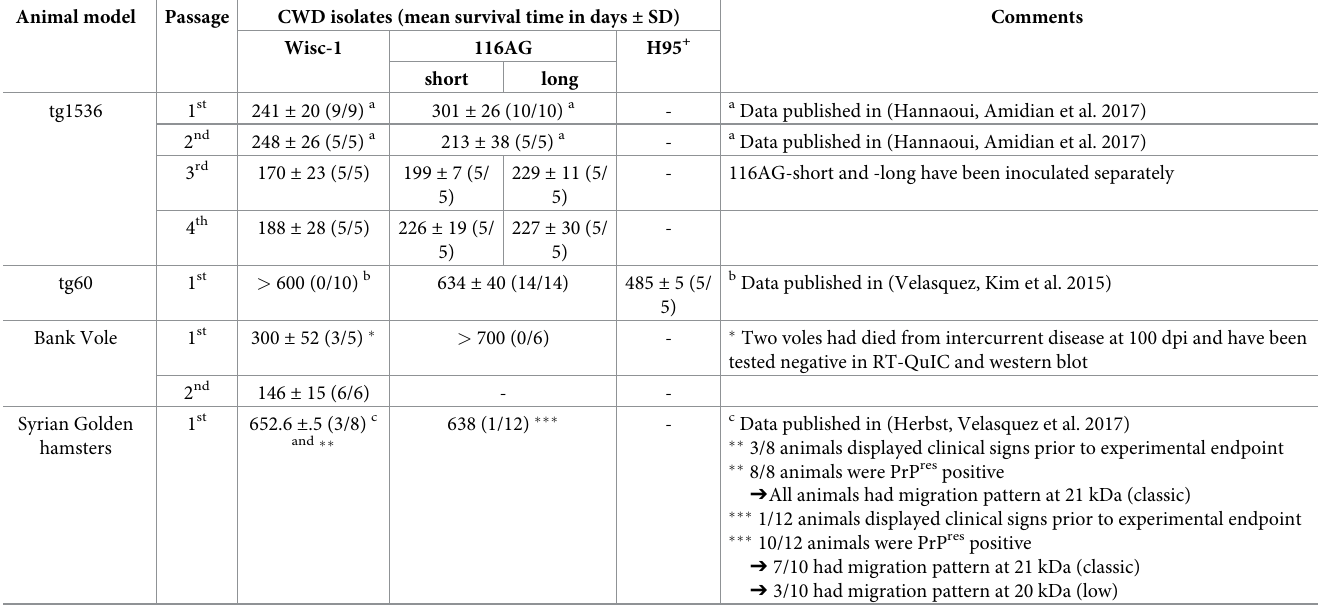
Table 1. Transmission of WTD isolates in different rodent models. Animal model